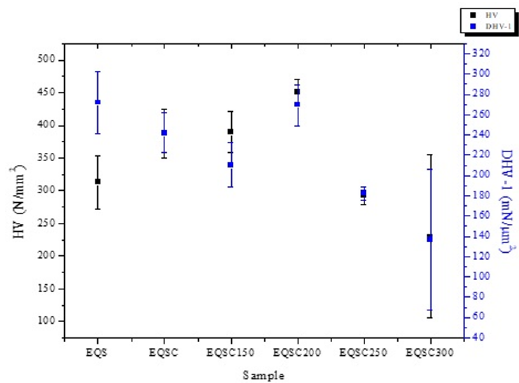
Figure 5. Penetration strength (classical Vickers hardness) and dynamic elastoplastic hardness for the different kinds of samples studied in this work.